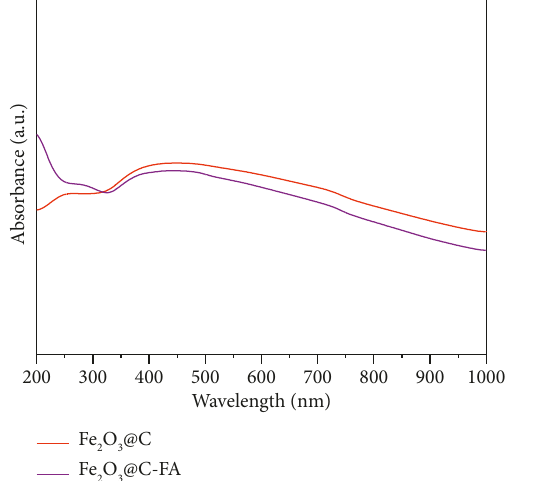
Figure 3: The absorbance spectra of Fe 3 O 4 @C and Fe 3 O 4 @C-FA. Figure 4: The FT-IR spectra of Fe 3 O 4 @C and Fe 3 O 4